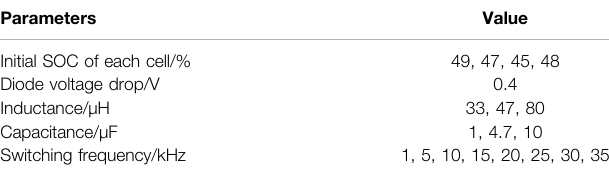
TABLE 1 | Battery parameters. TABLE 2 | Simulation parameters of the balancing